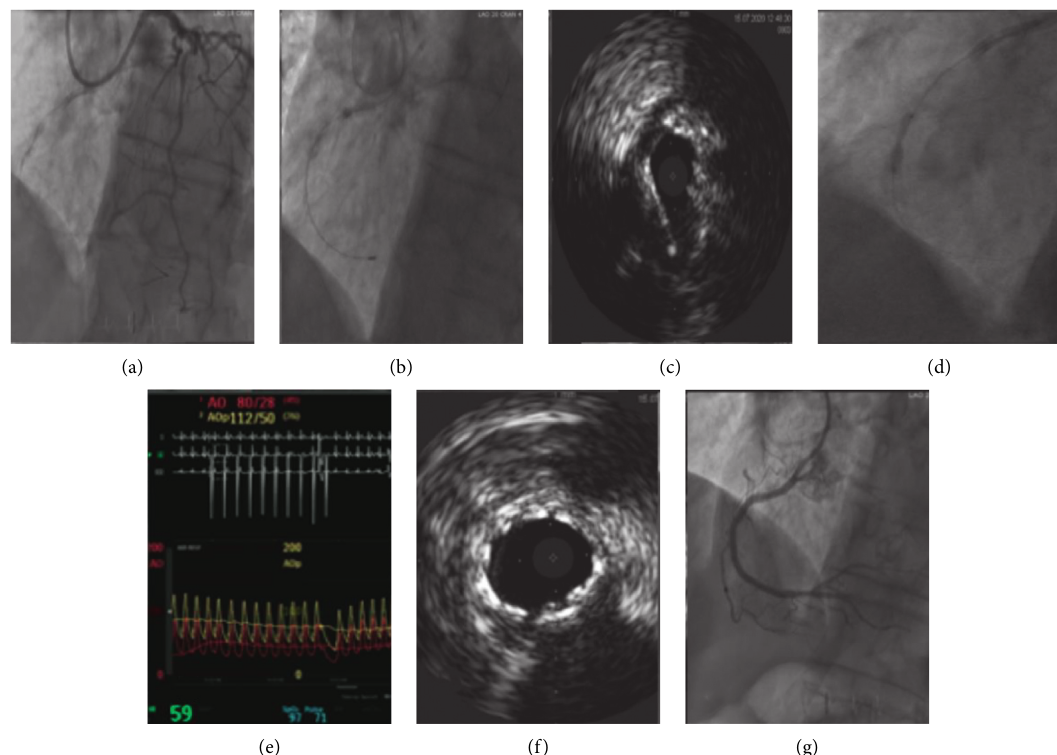
Figure 3: Calcium modification of mid-RCA CTO with RA and IVL. (a) Angiographic severe calcification mid-RCA; (b) RA; (c) IVUS confirmed intraplaque crossing with concentric calcium; (d) IVL with dogbone; (e) “Shocktopics” on EKG; (f) IVUS confirmed stent expansion; (g) final angiographic result.